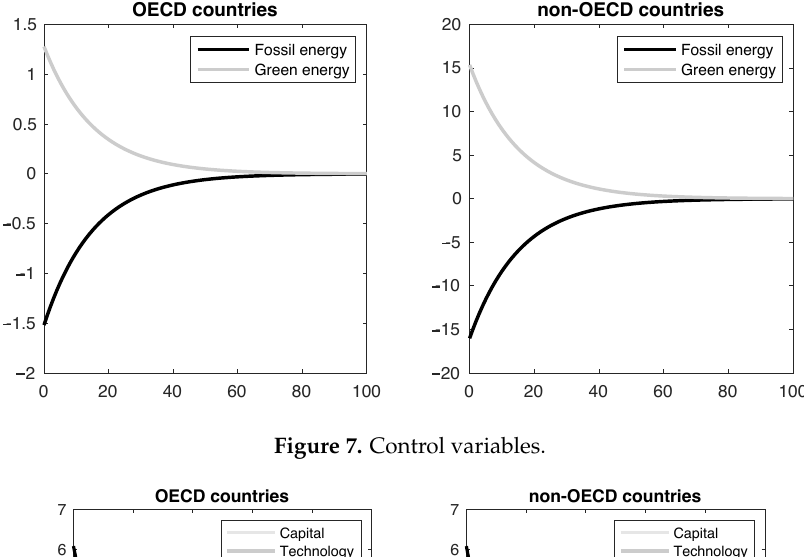
Figure 7. Control variables.